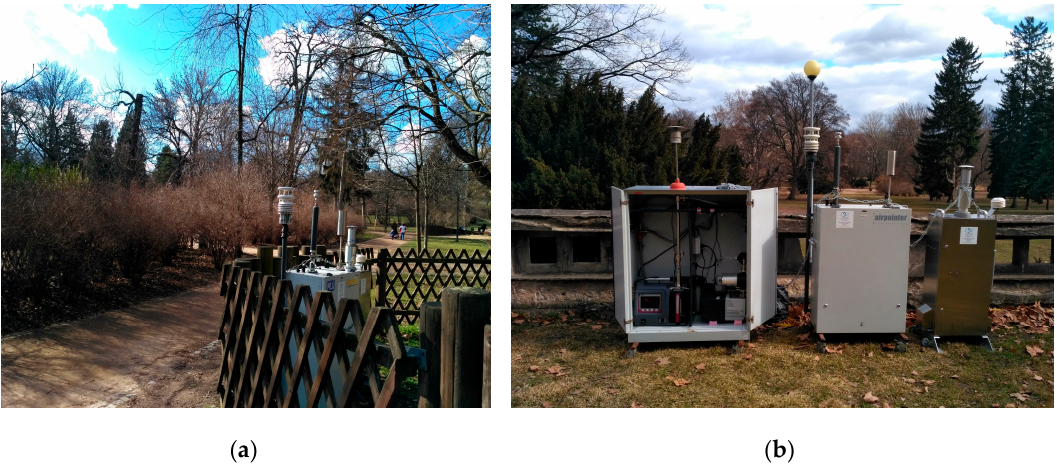
Figure 2. The devices at Lužánky: ( a ) Svojsík's Cabin; ( b ) Leisure Centre.